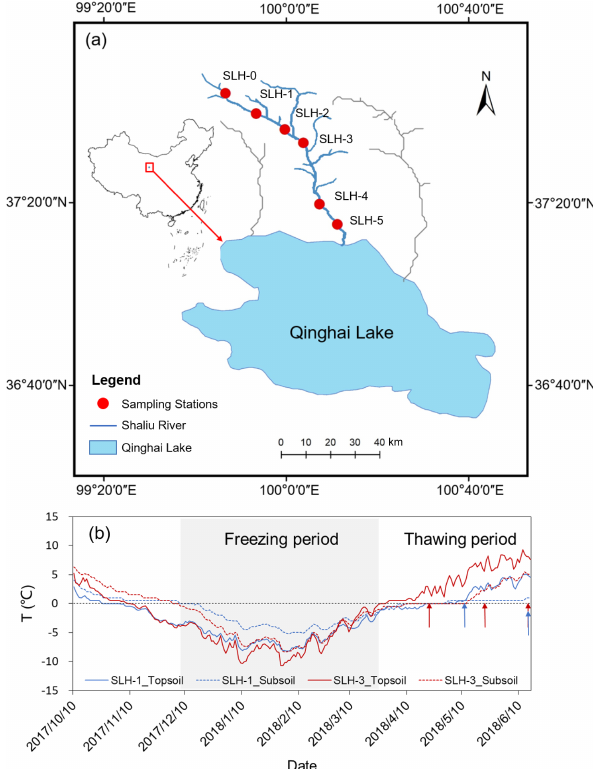
Figure 1. Sampling sites along the Shaliu River (a) and soil tem- perature ( T ) at the depth of 10cm (referred to as topsoil) and 40cm (subsoil) at SLH-1 and SLH-3 stations (b) . The map in panel (a) is processed with ArcGIS 10.0. The blue and red arrows in panel (b) indicate the sampling time for soil solution at SLH-1 and SLH-3 during thawing events,